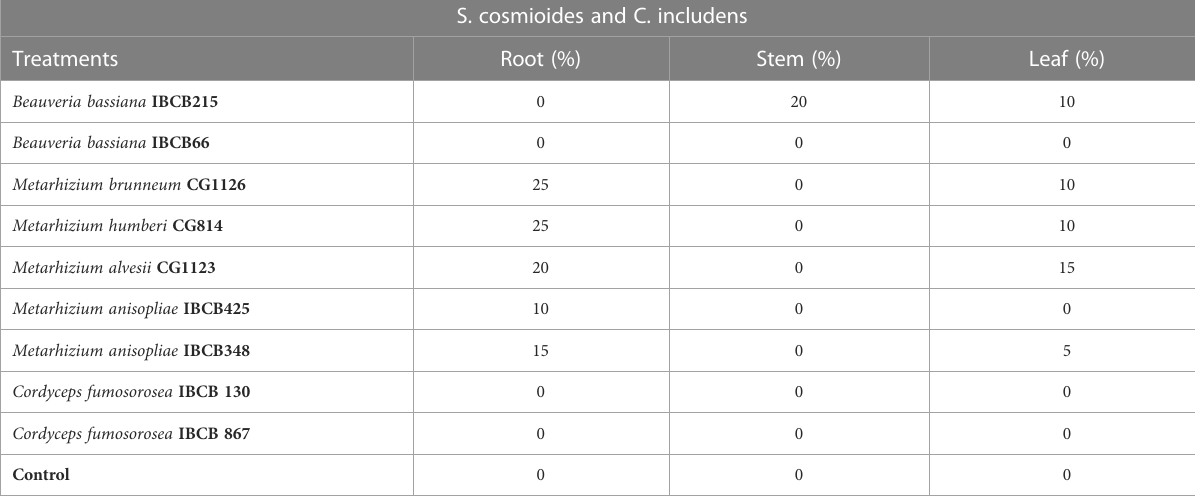
TABLE 7 Occurrence (%) of entomopathogenic fungi in peanut plant fragments at 30 days after inoculation. S. cosmioides and C. includens